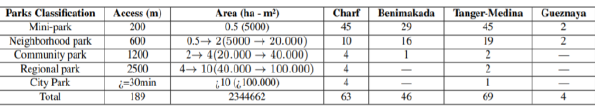
Table 1 . The Tangier urban park types